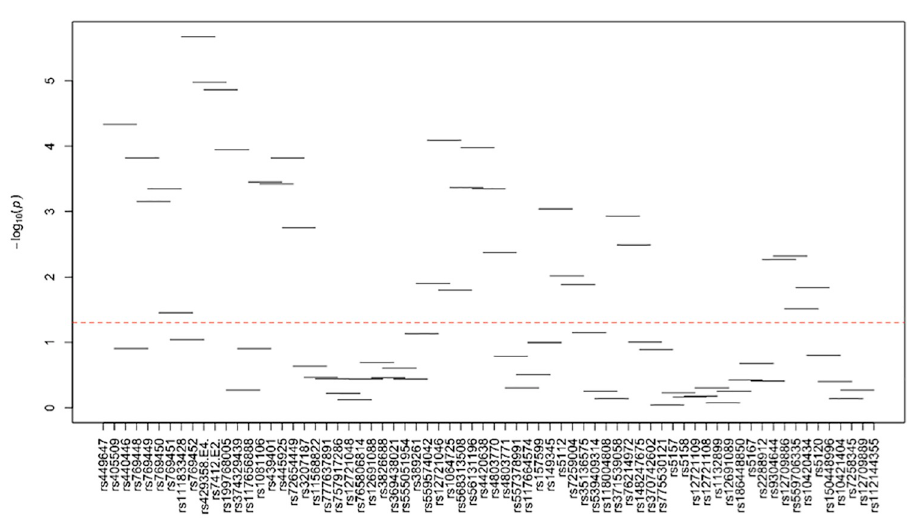
Fig 5. Plots of haplotype-based association analysis results for TC in NHWs. Horizontal lines represent the 4-SNP windows. X-axis direction shows the SNPs genotyped in the regions based on the order of APOE , APOC1 , HCR1 , HCR2 , APOC4 and APOC2 while the Y-axis shows the–log (global p-value) with red line representing the p-value threshold (P = 0.05).